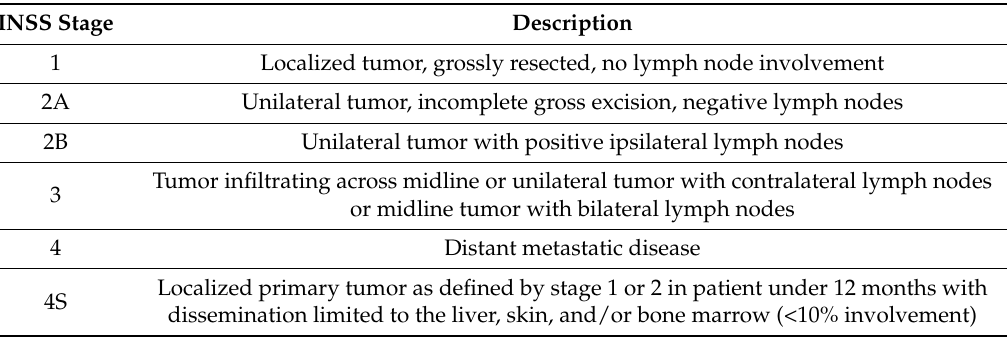
Table 1. International Neuroblastoma Staging System (INSS).